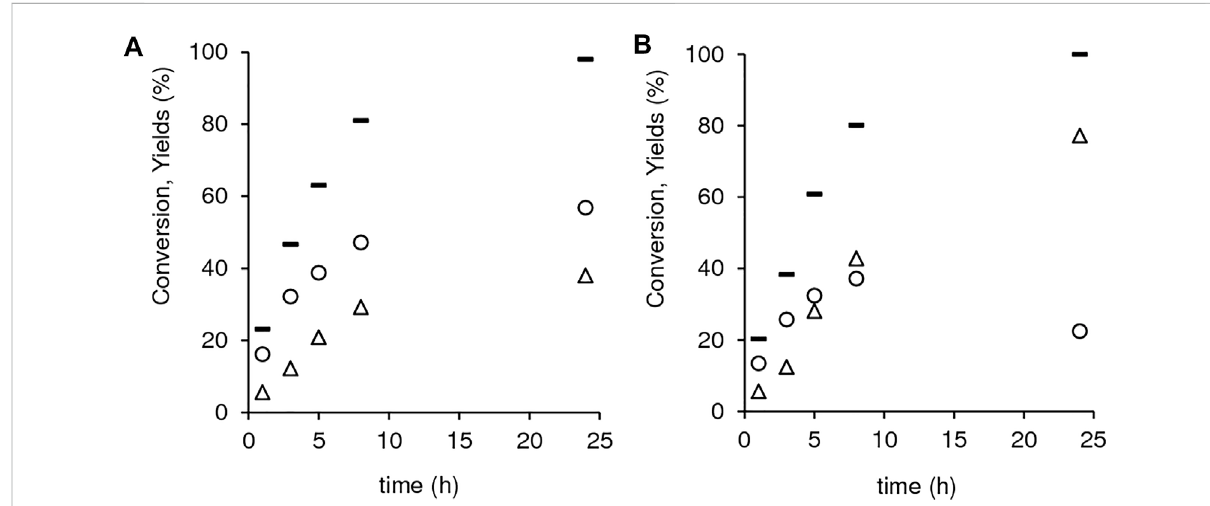
FIGURE 11 DependencyofLAconversion(-),GVLyield( Δ )and2BLyield(o)onreactiontimefor1.40Hf-D-HL(0.15) (A) and1.12Hf-D-HL(0.28) (B) .Reaction conditions: 0.45 M LA in 2BuOH, 25.5 g cat L − 1 , 200 °